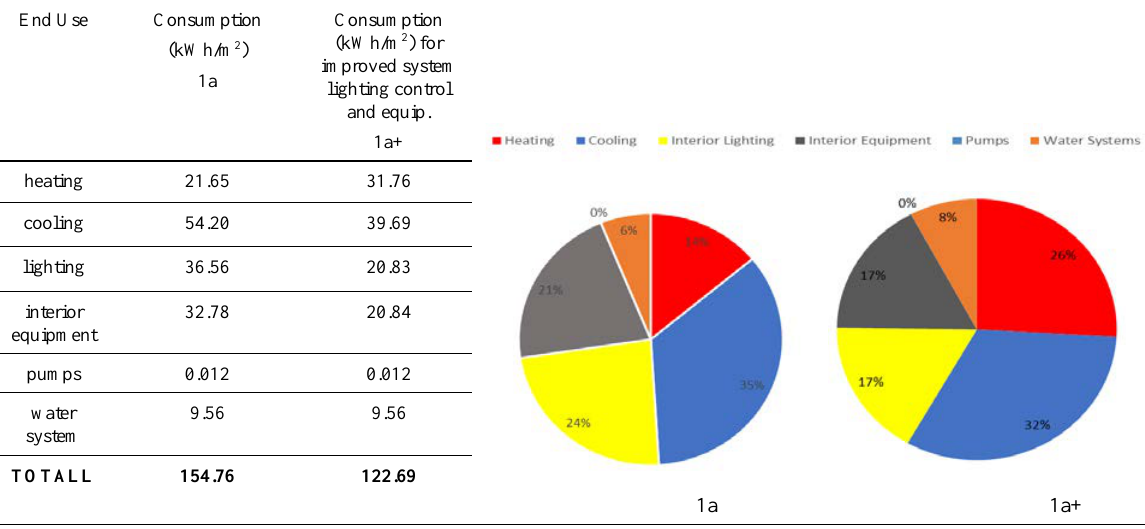
Table 6. Energy consumption for a newly designed model and total consumption percentage (double glazed units)